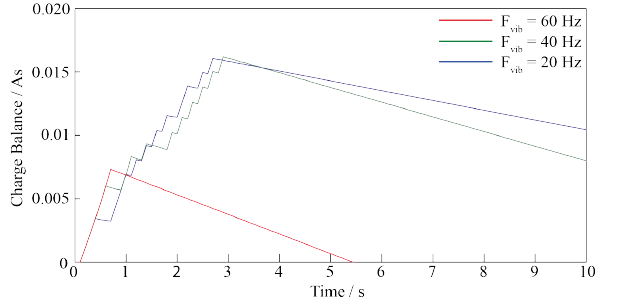
8 Figure 13. Simulated charge balance of the start-up phase. Figure 13. Simulated charge balance of the start-up phase. Figure 13. Simulated charge balance of the start-up phase. Figure 11. Desired transient response of the accelerated pendulum.